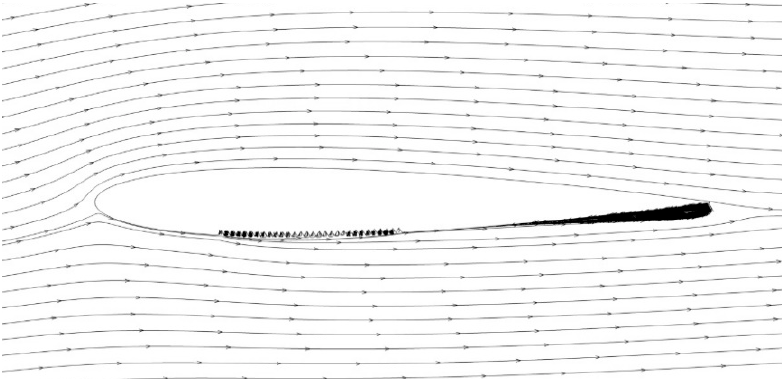
Figure 20. 4° angle of attack, streamline of grooves on the pressure side.